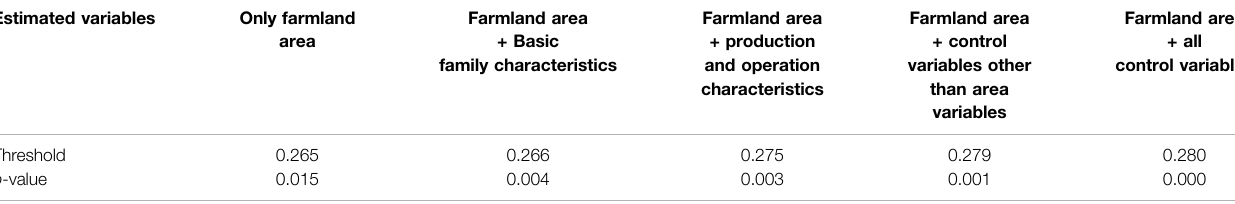
TABLE 6 | Threshold robustness test. Estimated variables